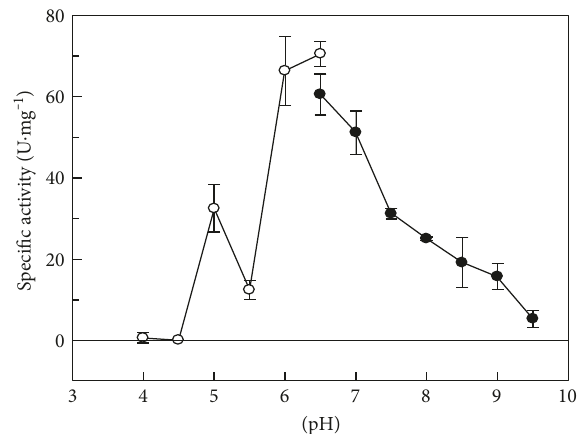
Figure 1: E ff ect of pH on the speci fi c activity of ComC in the reduction reaction. Two bu ff ers were used; ○ = 50 mM citrate bu ff er and ● = 50 mM BTP. Other assay conditions were standard; 37 ° C and 400mM KCl. Assays were carried out in at least triplicate. One unit of activity (U) is de fi ned as the conversion of one μ mol of NADH to NAD + per minute under standard assay conditions.